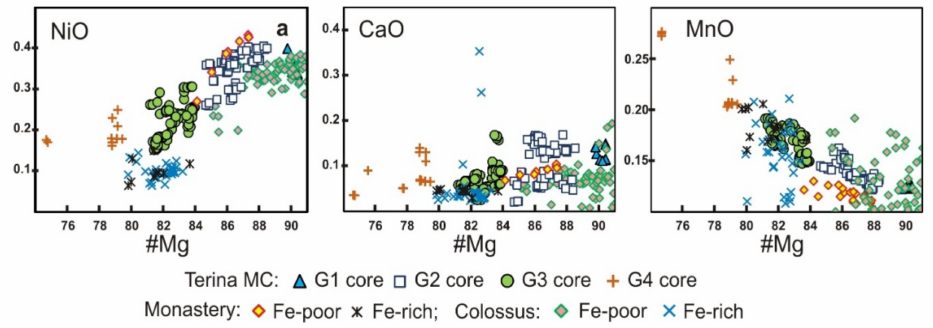
Figure 10. NiO, CaO, MnO (wt%) vs. Mg# for olivine macrocrysts from the aillikites of the Terina complex, as well as for macrocrysts from the Cr-poor megacryst suite of the Colossus [22] and Monastery [46,59] kimberlites are given. Terina MC—olivine macrocrysts of Terina (legend as in Figure 4); Fe-poor: low-Fe olivines, Fe-rich: high-Fe olivines. The positive correlation between Ca and Al is observed for the ( G2a ), ( G3 ), and ( G4 ) macrocrysts. In addition, the decreased concentration of these components coupled with Fe increase can be noticed. Such patterns can be caused by co-crystallization of olivine along with the Ca-Al phase (likely clinopyroxene) from the